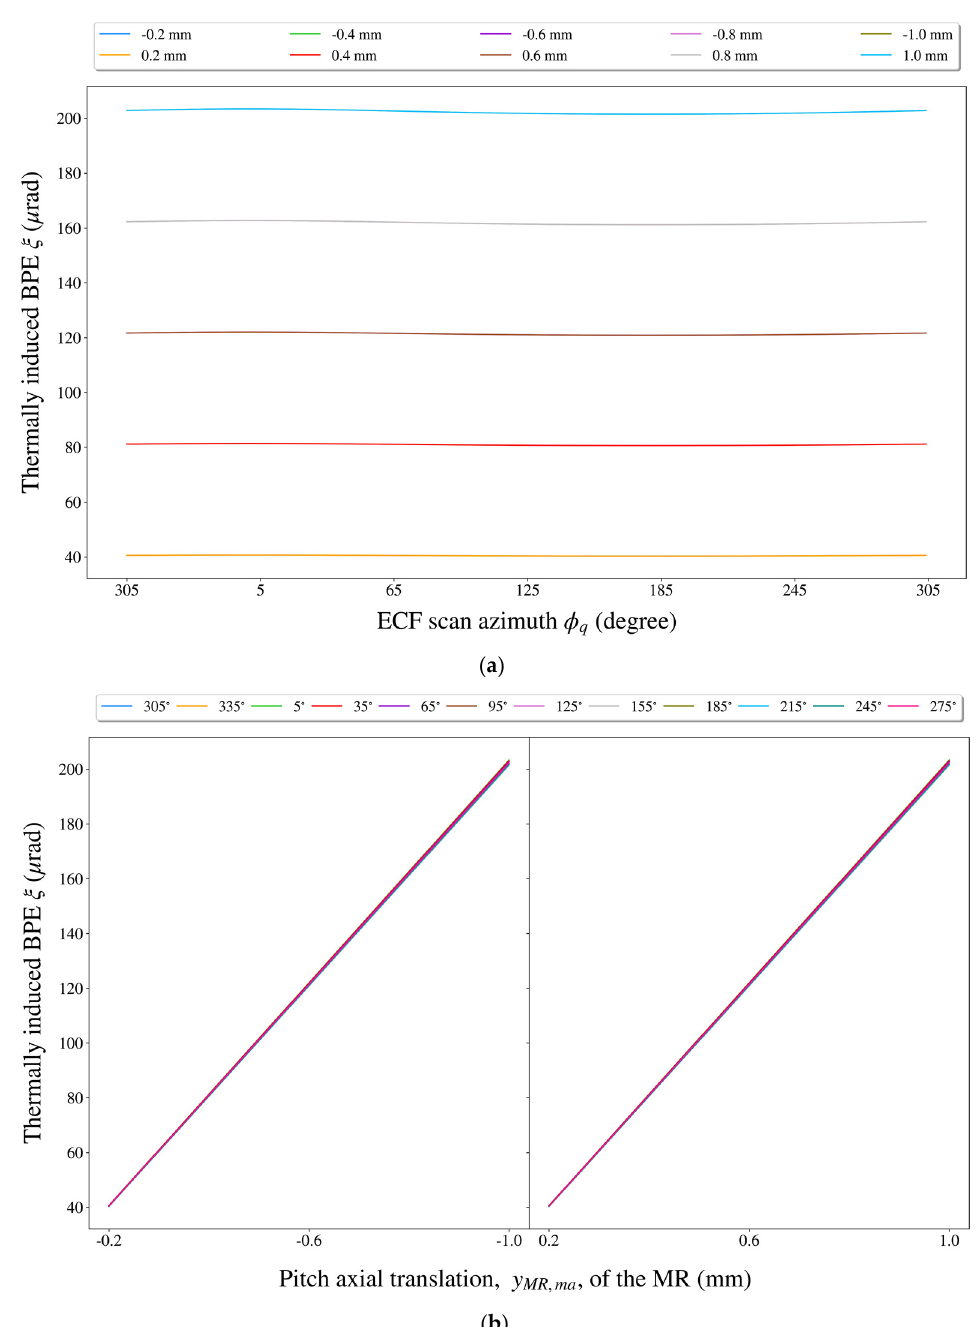
Figure 9. The impact of the pitch axial translation (cid:1877) MR,(cid:3040)(cid:3028) of the MR on the BPE. (a) The variation of the BPE with respect to the ECF scan azimuth at some fixed levels of (cid:1877) MR,(cid:3040)(cid:3028) . (b) The variation of the BPE with respect to (cid:1877) MR,(cid:3040)(cid:3028) at some fixed ECF scan